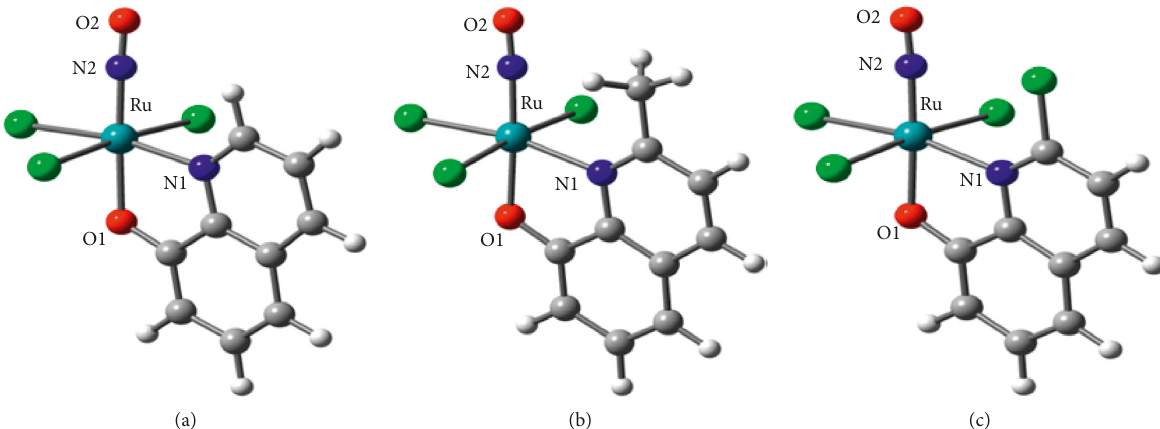
− (a), [RuCl − (b), and [RuCl − (c) complexes. 3 (hqn)NO] 3 (2mqn)NO] 3 (2cqn)NO]